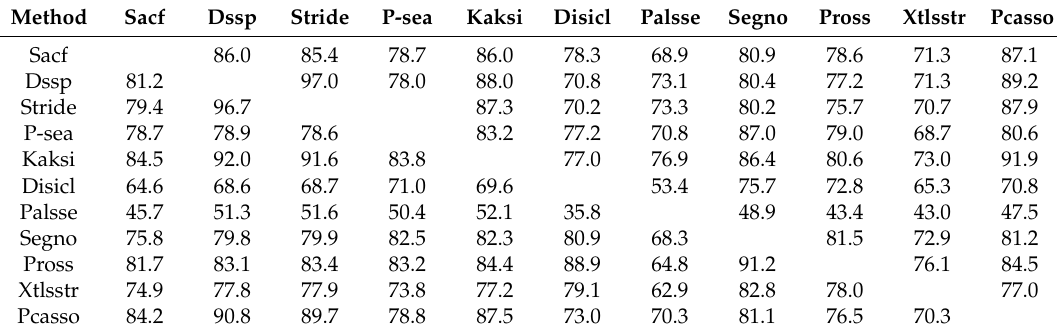
Table 3. SOV scores (%) between any two of eleven methods on Set T for β -sheet. For every SOV score in the table, the corresponding method in the first column is taken as the reference